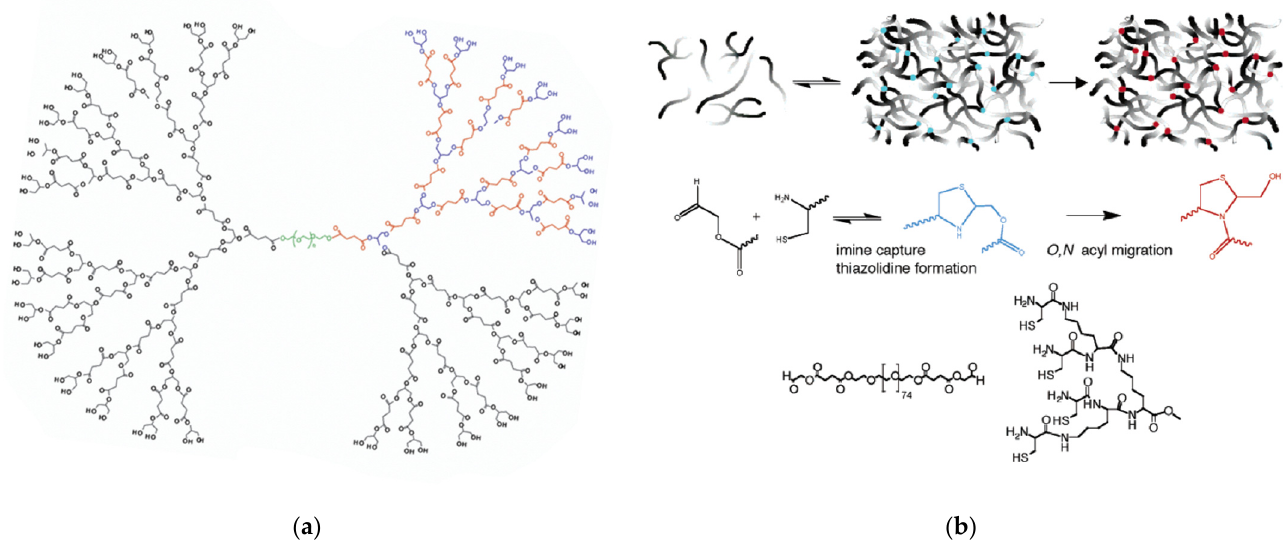
Figure 27. ( a ) Polyester dendrimer with a linear poly(ethylene glycol) core. Reproduced with permission from [255]. Copyright: American Chemical Society; ( b ) Crosslinking mechanism for the pseudoproline ligation between poly(ethylene glycol diester-aldehyde and N-terminal cysteine lysine dendrons for hydrogel formation. Reproduced with permission from [260] Copyright: American Chemical Society.